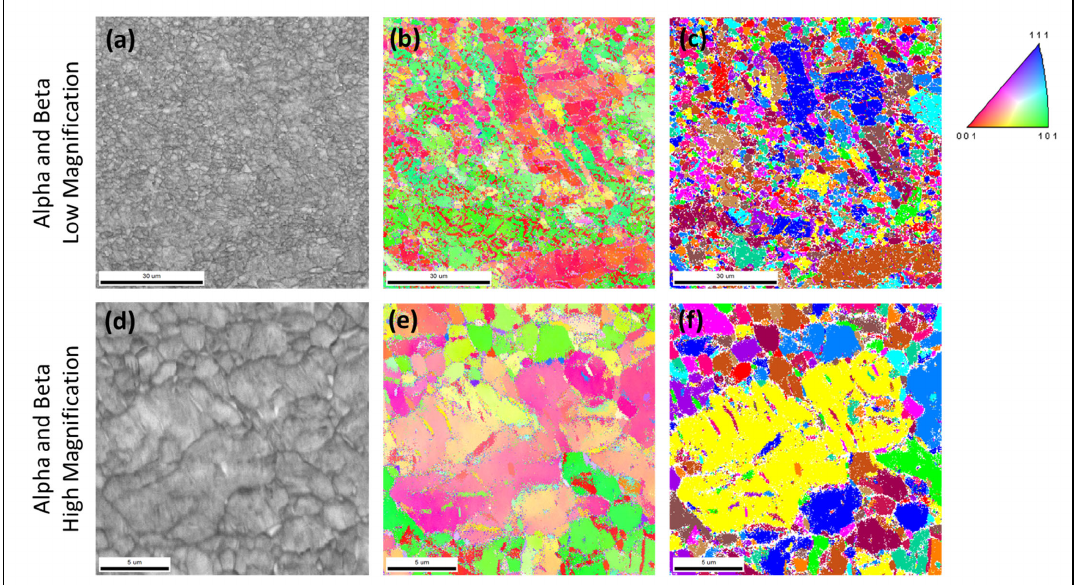
Figure 17. Electron backscatter diffraction (EBSD) band contrast maps, phase maps, and orientation maps of alpha and beta. Low magnification ( a – c ) and high magnification ( d – f ).